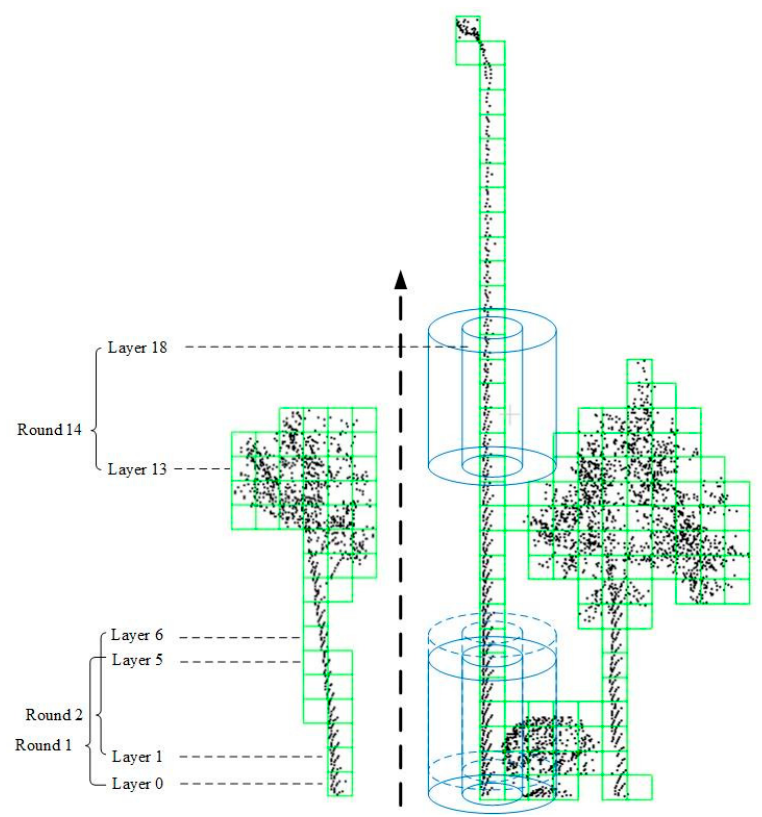
Figure 4. An isolation analysis example for voxels.